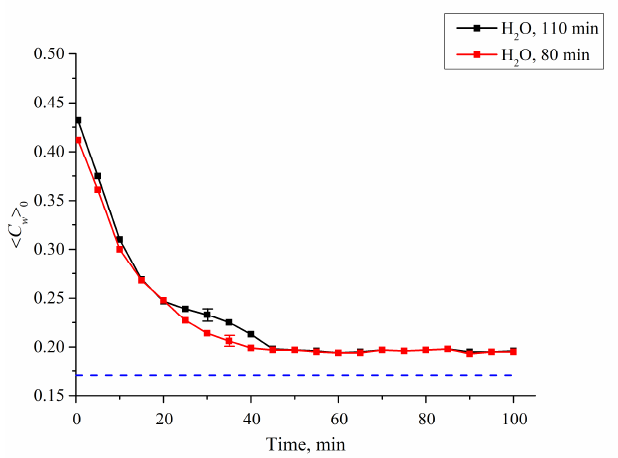
Figure 9. Average (over the Nafion plate thickness L 0 = 175 μm) water concentration C w ( t ) 0 inside the membrane vs. the time of drying after soaking within 80 and 110 min in the cell with the distance between the windows as L = 180 μm. It is seen that the dynamics of drying are different for the times 80 and 110 min. The dashed line is the water concentration for dry Nafion (baseline).